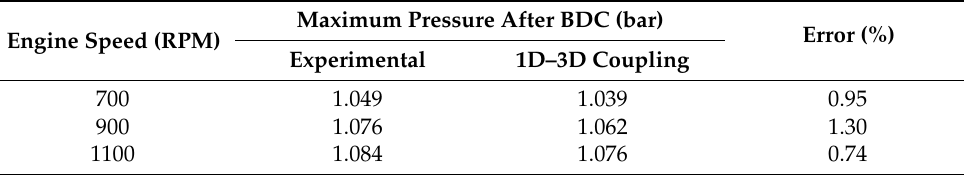
Table 4. Maximum pressure results of the exhaust pipe after BDC according to the engine speed.